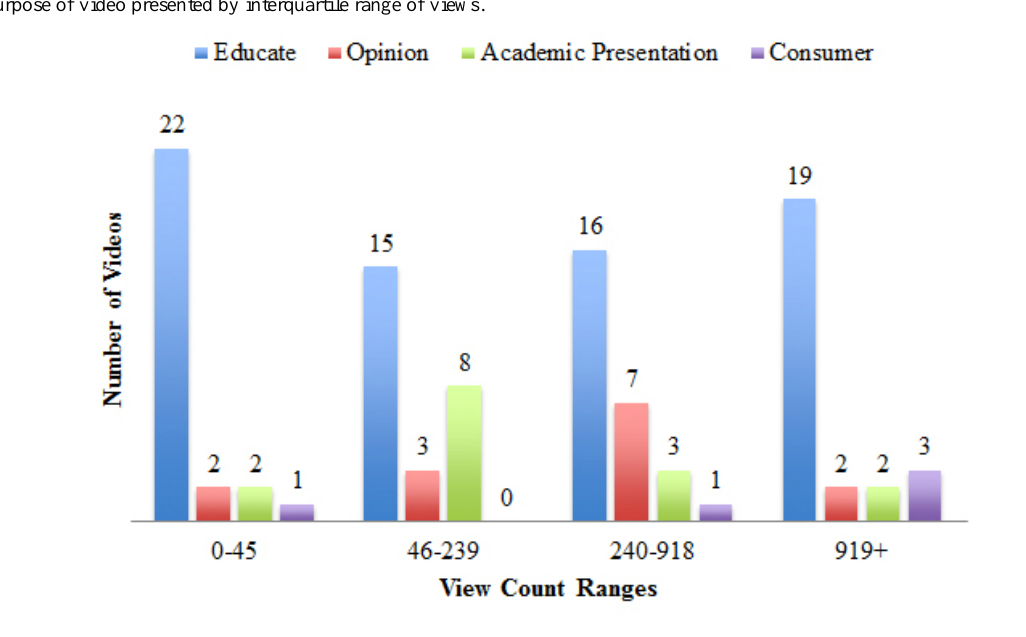
Figure 5. Purpose of video presented by interquartile range of